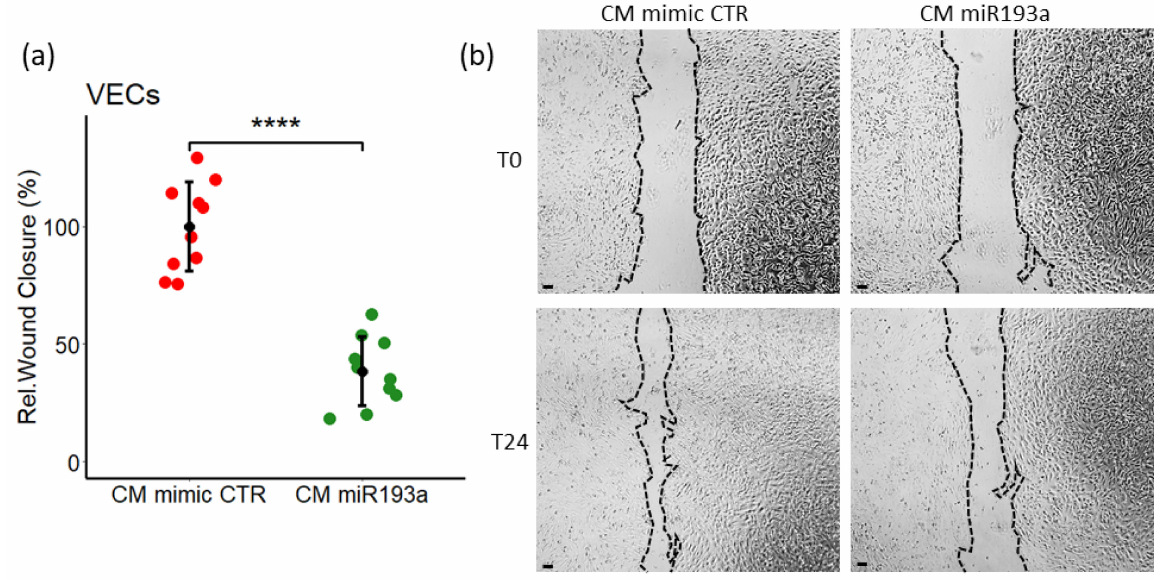
Figure 4. Secretome/CM from miR193a-3p transfected MCF-7 cells inhibits VEC migration/wound closure. Cell migration, was investigated using wound closure assay in confluent VECs